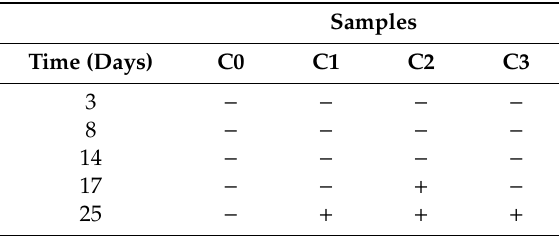
Table 5. Mold and yeast count in cupcake